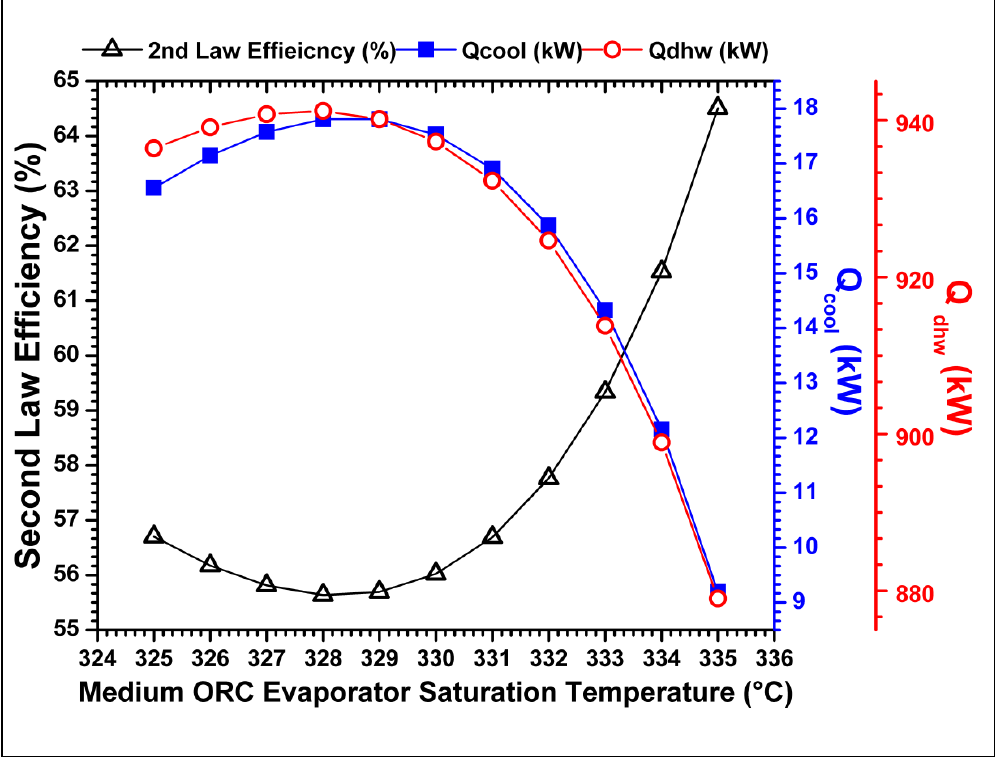
Figure 4. The variation of the cooling, heating, and second law efficiency against the saturation evaporation temperature of the medium temperature heat source powered ORC.